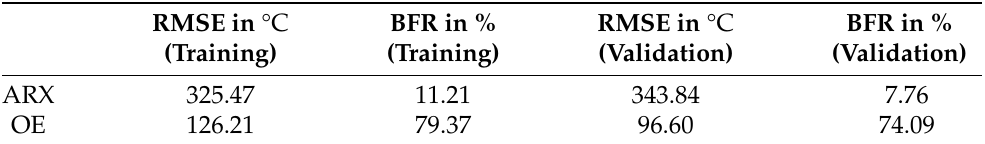
Table 2. Performance of ARX and OE models for simulation assessed for training and validation data, respectively, for single track case.